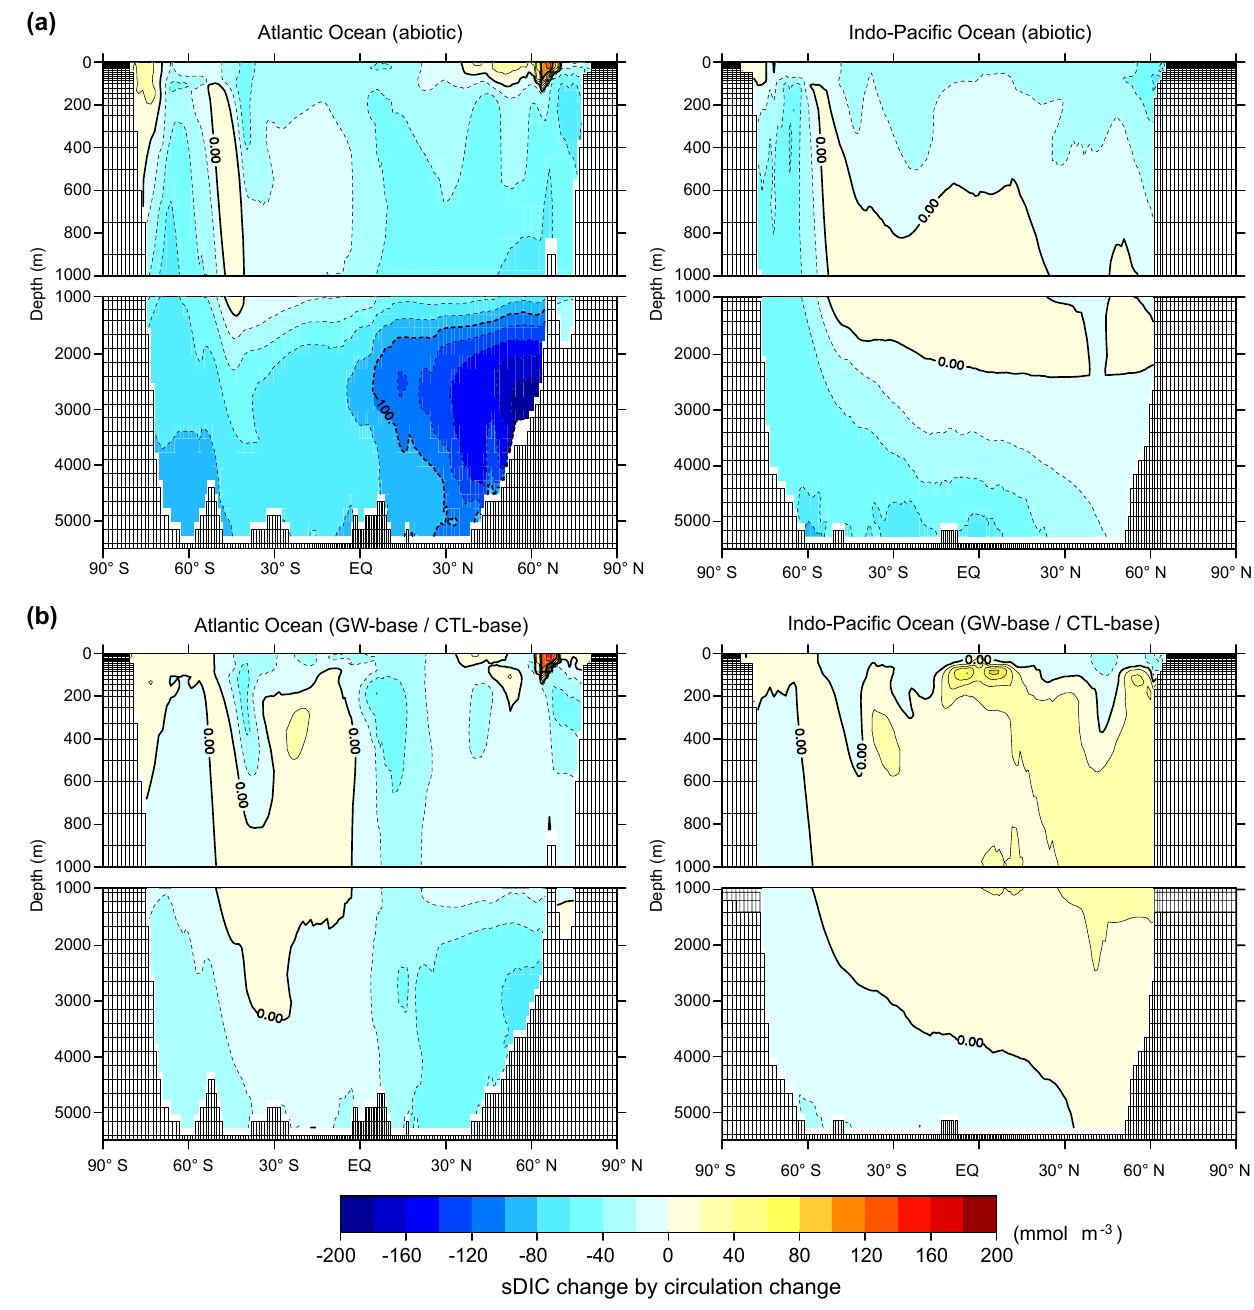
Figure 6. Zonal mean changes in the salinity-normalized DIC induced by circulation changes for (a) the abiotic experiments and (b) the CTL-base and GW-base experiments at 500 years. The left and right panels show the Atlantic and Indo-Pacific oceans,